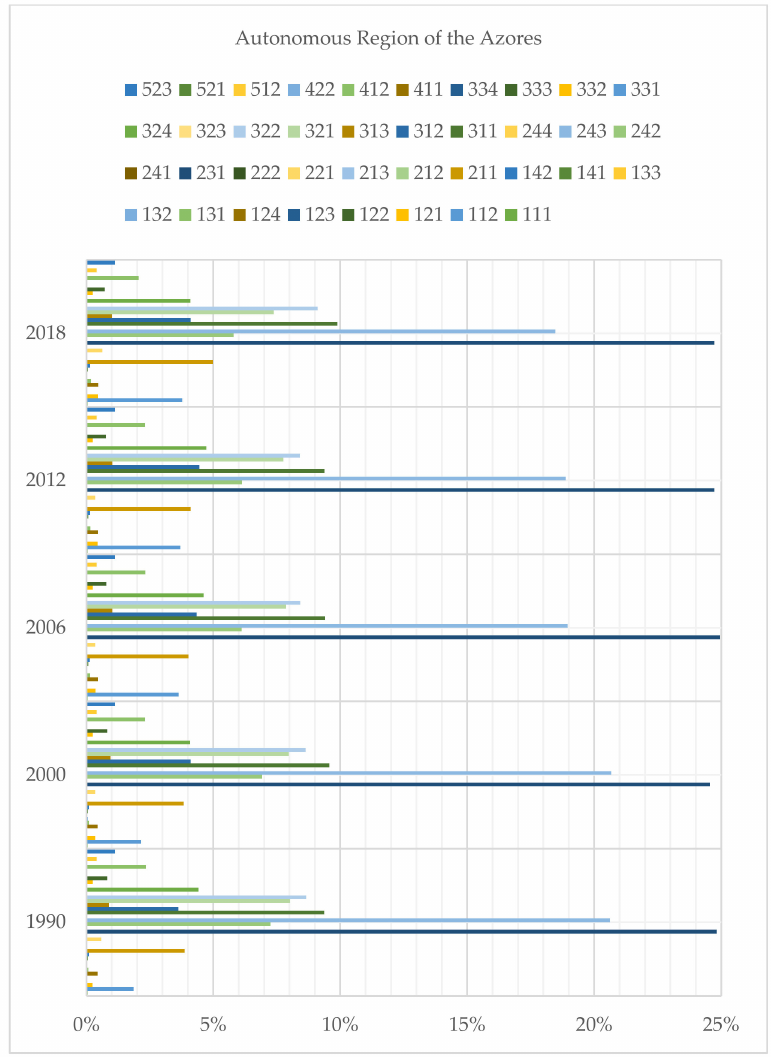
Figure 6. Percentage of land-uses according to CLC nomenclature in the Autonomous Region of the